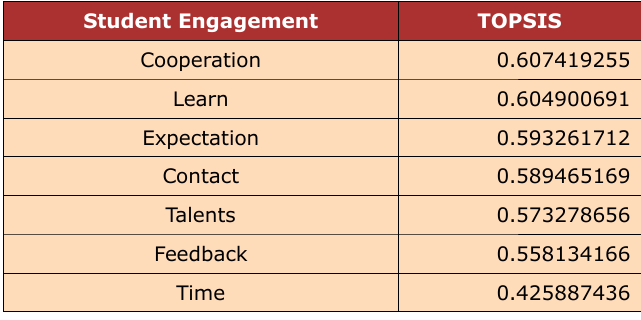
Table 5. TOPSIS value for student engagement